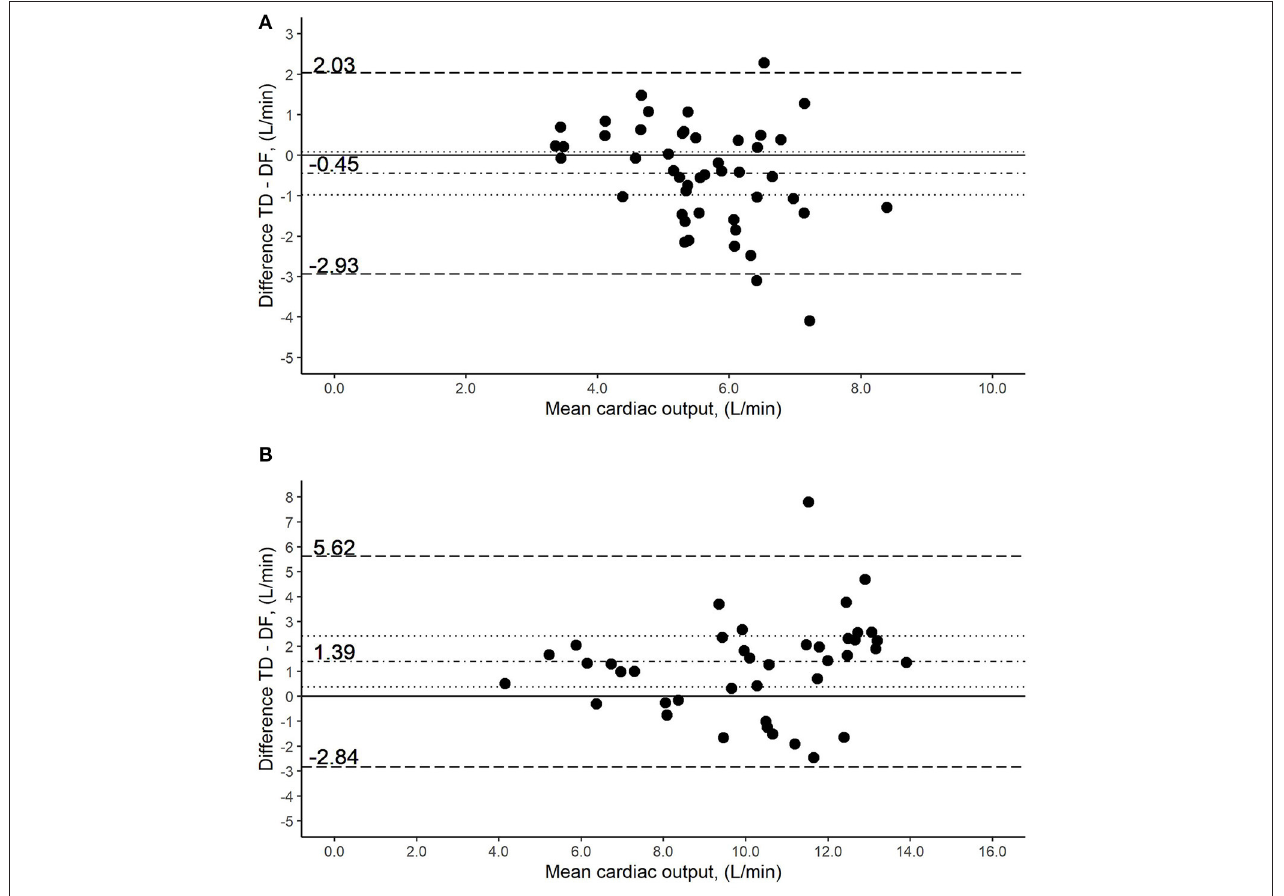
FIGURE 4 | Bland-Altman plot of the comparison of cardiac output (CO) measurement methods by intermittent thermodilution (TD) vs. direct Fick using blood gases (DF). Y-axis was calculated as the mean of the two methods being compared. The solid line represents no difference in the means by the two methods. The dot-dashed line around zero represents the measured difference of the means, while the dotted lines stand for the 95% CI. The broken lines above and under it, represent the limits of agreements. (A) Measurements at rest: the difference in the means (bias) was − 0.45 L/min (95% CI, − 0.98 to 0.08 L/min), with the lower and upper limits of the agreement being − 2.93 and 2.03 L/min, respectively. (B) Measurements at end-exercise: bias was 1.39 L/min (95% CI, 0.37–2.42 L/min), with the lower and upper limits of the agreement being − 2.84 and 5.62 L/min,